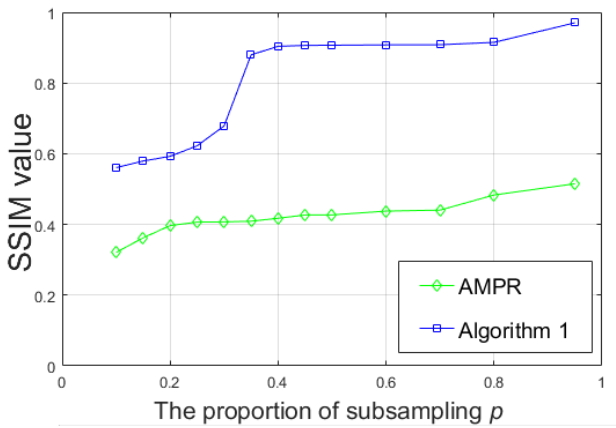
Figure 9. In SSIM at different sampling rates.